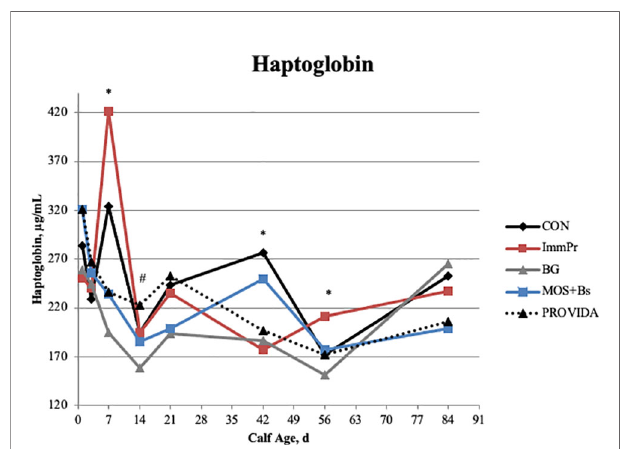
FIGURE 5 | Serum haptoglobin concentration was measured on d 0, 3, 7, 14, 21, 42, 56, and 84. There was a treatment x time interaction ( P ≤ 0.010). On d 7 ImmPr had greater haptoglobin concentrations than BG, MOS+Bs, and PROVIDA ( P ≤ 0.015). On d 14, BG had decreased haptoglobin when compared to CON, ImmPr, and PROVIDA ( P ≤ 0.068). The CON treatment had greater concentrations on d 42 than ImmPr, BG, and PROVIDA ( P ≤ 0.016). On d 56 ImmPr had the greatest haptoglobin concentrations ( P ≤ 0.035). Largest SEM per time point are expressed as m g/mL and include 31.202, 24.013, 61.286, 19.575, 29.605, 31.639, 16.917, and 45.241 for d 1, 3, 7, 14, 21, 42, 56, and 84, respectively. An * indicates a treatment difference of ( P ≤ 0.05)